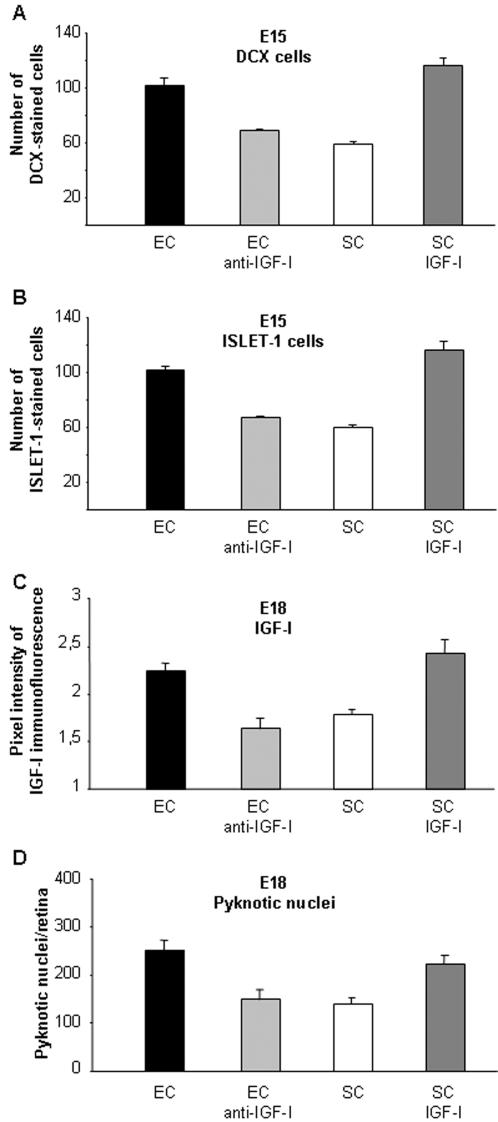
IGF-I is the mediator of maternal enrichment effects on retinal development in the fetus.Number of DCX (A) and of ISLET-1 (B) positive cells in the outer retinal layers of EC, anti-IGF-I EC, SC and IGF-I SC rats at E15. For both (A) and (B), one-way ANOVA showed an effect of the treatment (p<0.05). A difference was found between EC and SC, between EC and EC anti-IGF-I and between SC and SC IGF-I groups (p<0.05, Post-hoc Tukey test). Neither EC anti-IGF-I and SC groups nor EC and SC IGF-I groups were instead found to differ between each other. (C) Quantitative analysis of IGF-I immunofluorescence intensity in the RGC layer of EC, anti-IGF-I EC, SC and IGF-I SC rats at E18. (D) Pyknotic cell number of EC, anti-IGF-I EC, SC and IGF-I SC rats at E18. After treatment with anti-IGF-I, levels of IGF-I expression and number of pyknotic profiles in the RGC layer of EC fetuses were lowered to those of SC rats while, after chronic IGF-I protein infusion, levels of IGF-I expression and the number of pyknotic profiles in the RGC layer of SC fetuses were enhanced up to those of EC rats. For both (C) and (D), one-way ANOVA showed an effect of the housing treatment (p<0.001). A difference was found between EC and SC, between EC and EC anti-IGF-I and between SC and SC IGF-I groups (p<0.05, Post-hoc Tukey test). Neither EC anti-IGF-I and SC groups nor EC and SC IGF-I groups were instead found to differ between each other. The bars indicate s.e.m.